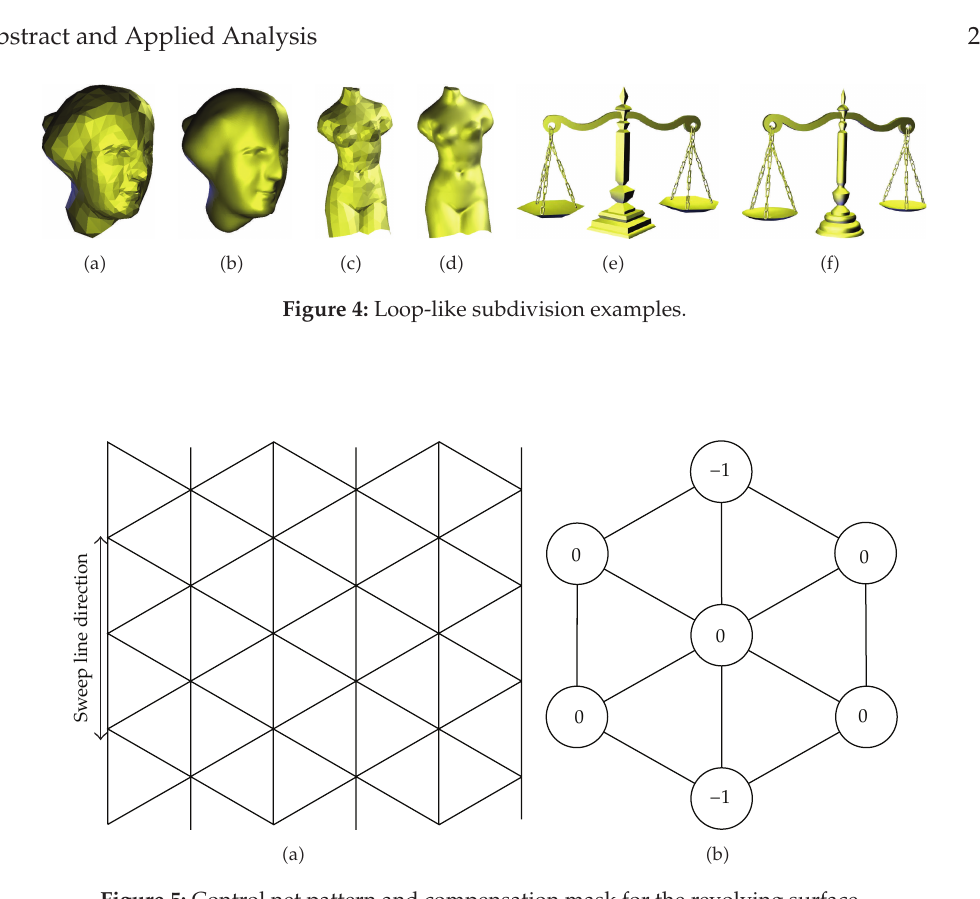
Figure 5: Control net pattern and compensation mask for the revolving